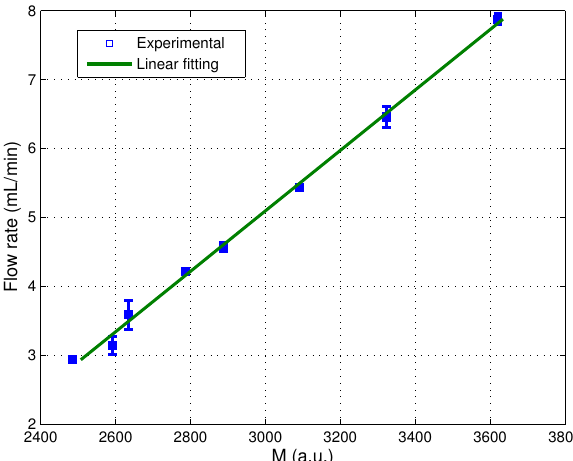
Figure 15. Measurement of the evolution of parameter M with the mean